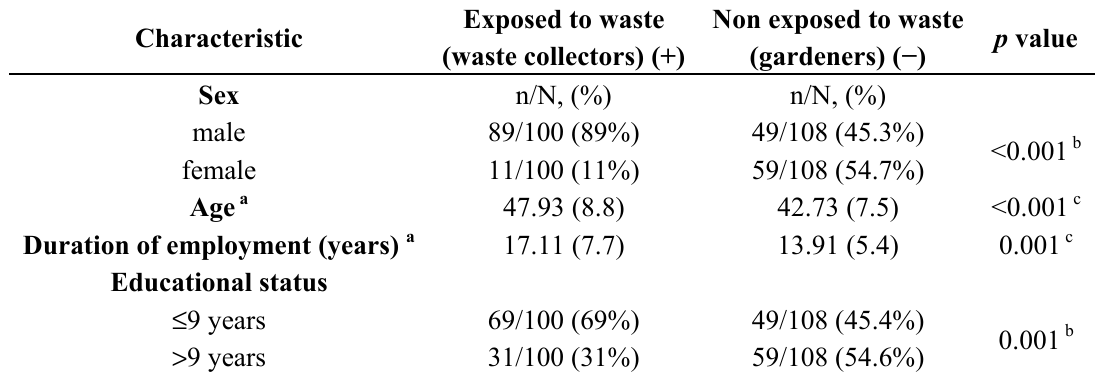
Table 1. Comparative analysis of socio-demographic characteristics by exposure status among municipal